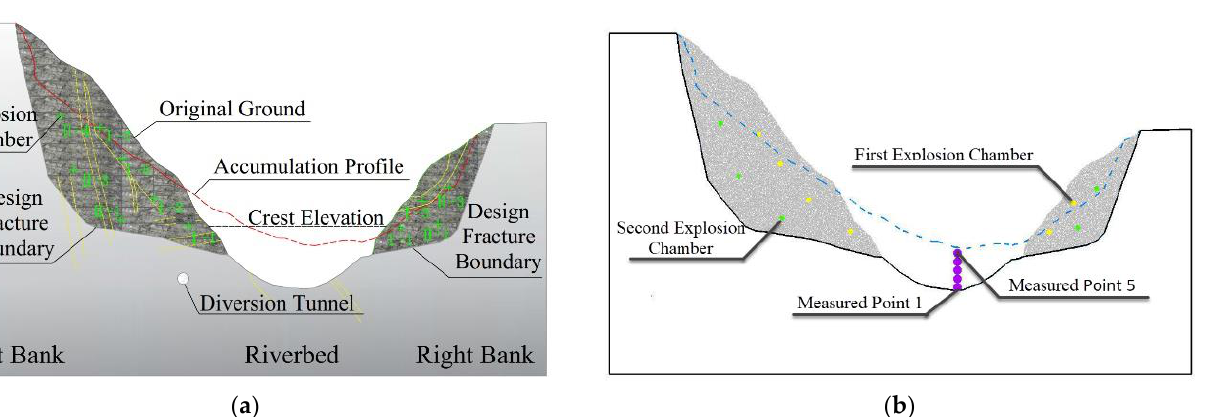
Table 3. Microparameters of the blast-fill dam.